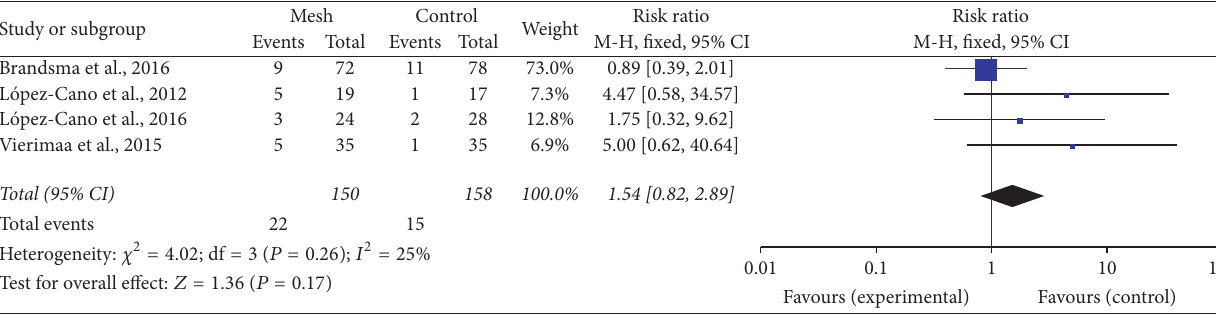
Figure 8: Forest plot for perineal wound infection.